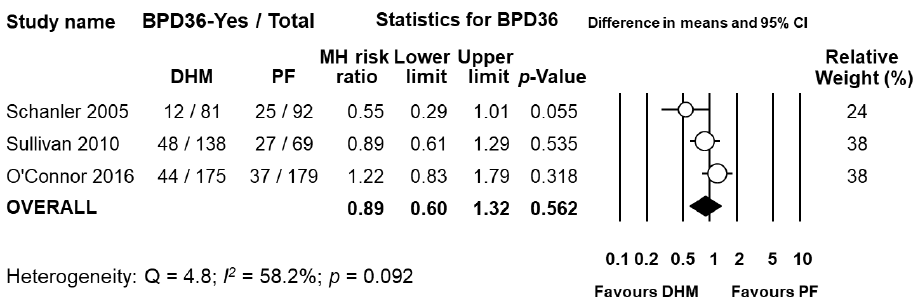
Figure 2. Meta-analysis of randomized controlled trials assessing the effects of supplementation of MOM with DHM, compared with supplementation with PF, on risk of BPD36. Circles (O) represent the effect sizes per study, and their size represents the relative weight of the study in the meta-analysis. Diamonds ( ◆ ) represent the pooled effect size. DHM: donor human milk; PF: preterm formula; BPD36: bronchopulmonary dysplasia defined as oxygen dependency at 36 weeks post-menstrual age; MH: Mantel-Haenszel.